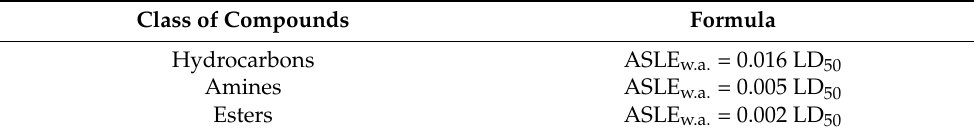
Figure 10. Forecast assessment of LCL ecological safety. Table 7. Formulas for calculating ASLE for LD 50